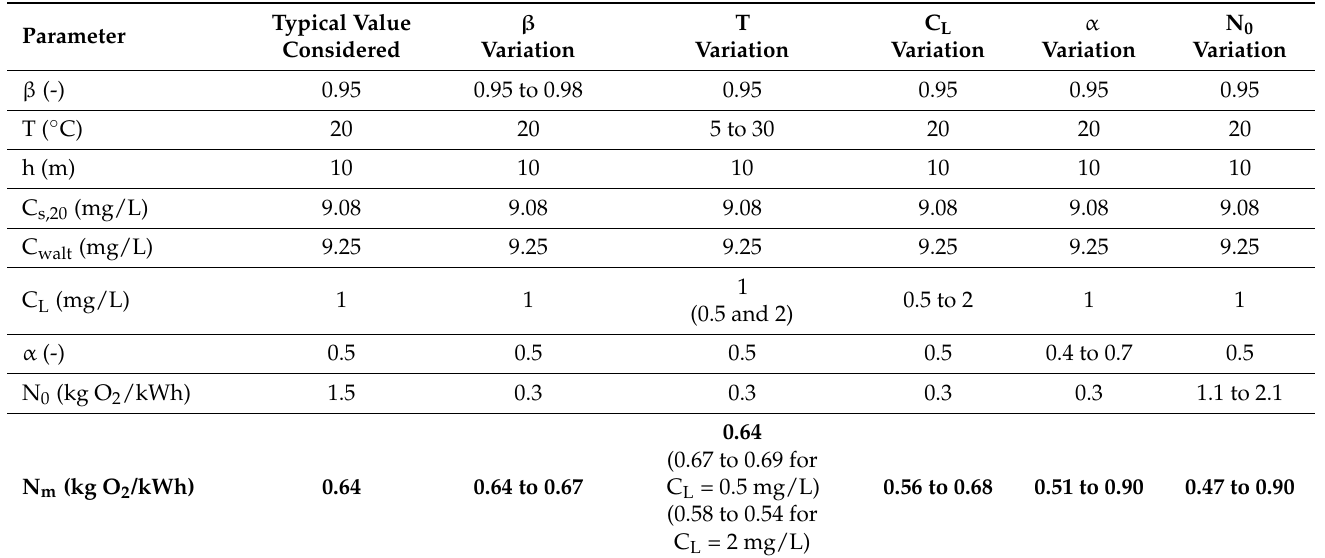
Table 14. The standard oxygen-transfer variation with each parameter of the mechanical